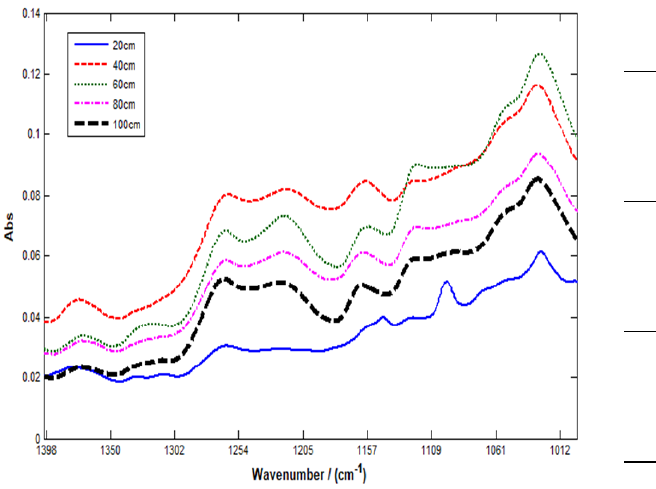
Figure 6. The spectral region of 1400–1000 cm -1 for uncultivated peat, distinguished according to depth.